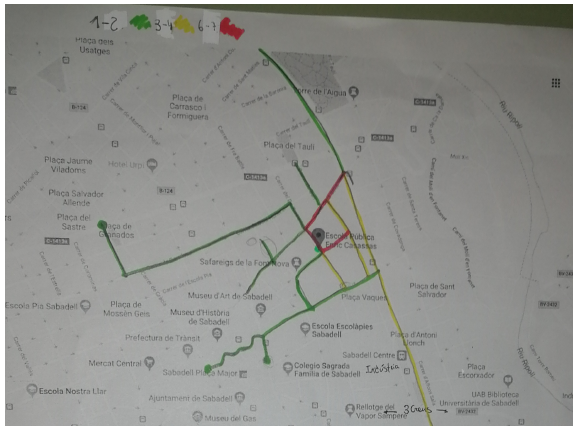
Figure 4. A map showing the intensity of use of the different routes taken to go to